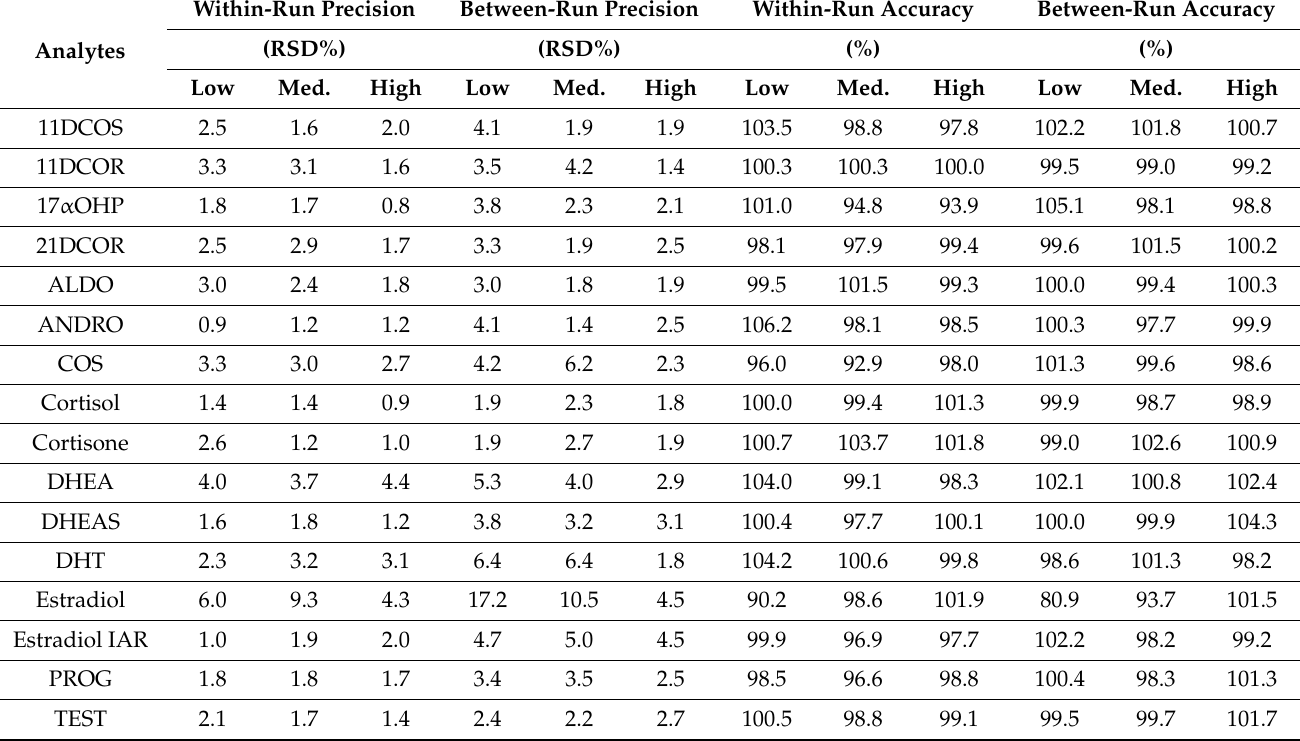
Table 3. Within-run and between-run precision, accuracy for each analyte. n =